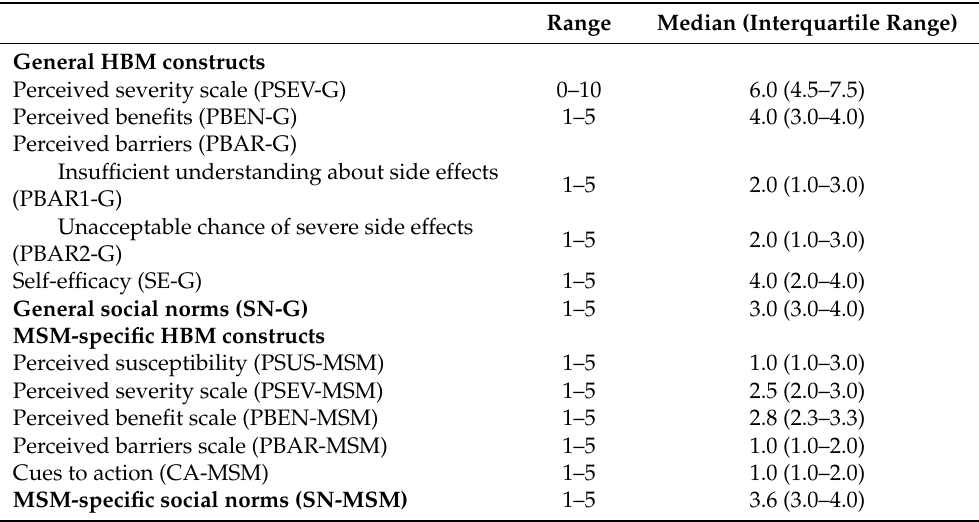
Table 2. Descriptive statistics of the key independent variables (n =